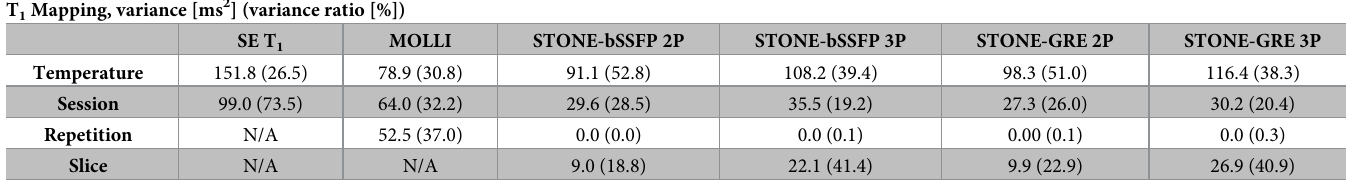
Table 1. Sources of variability in T 1 mapping defined by variance decomposition